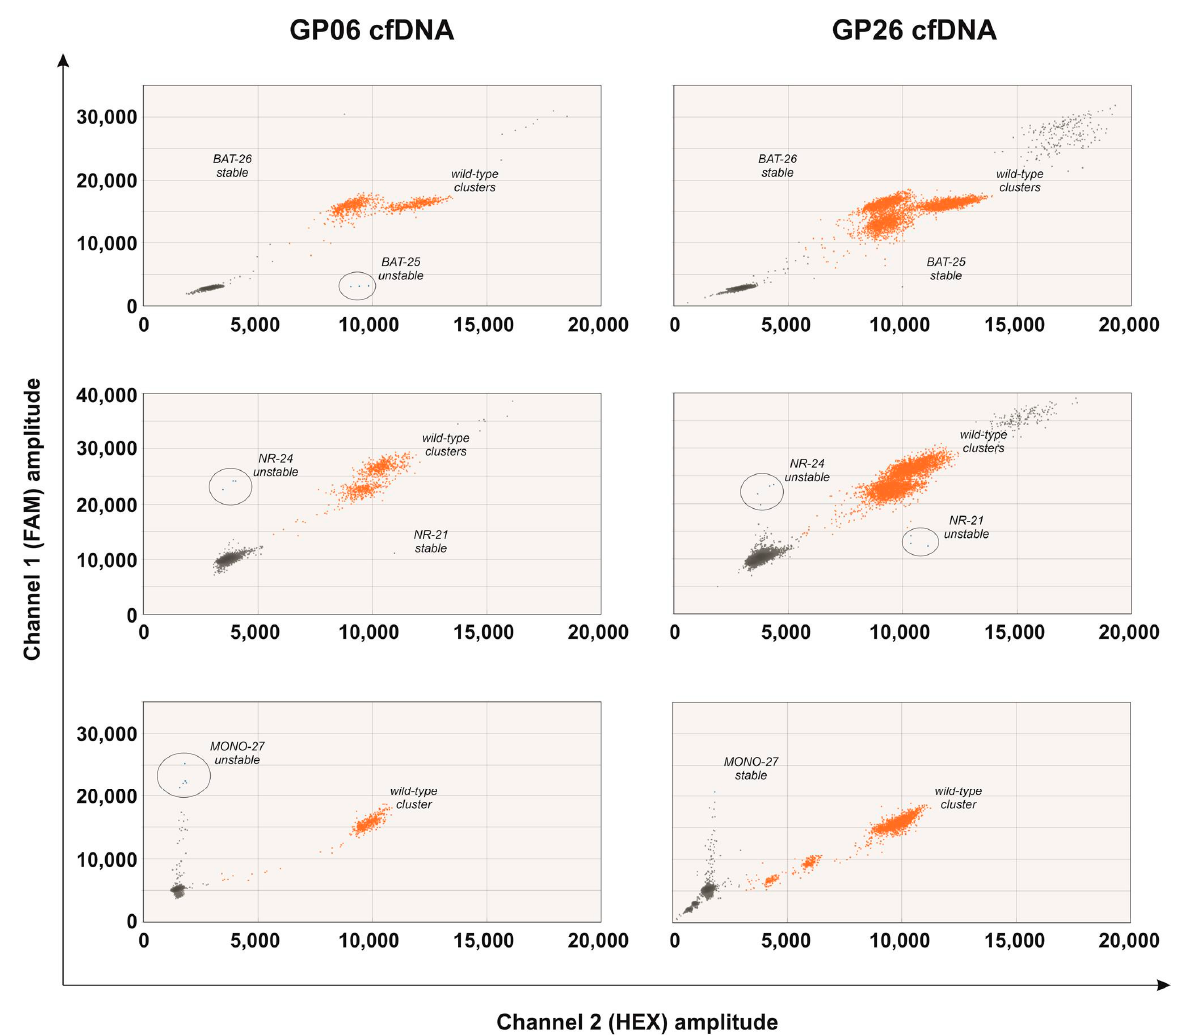
Figure 3. Two-dimensional plot of droplet fluorescence for the three ddPCR MSI assays (BAT-25 and BAT-26; NR-21 and NR-24 and MONO-27) performed in the cfDNA of patients GP06 and GP26. Wild-type molecules are in the orange clusters, and the microsatellite unstable molecules are in the blue clusters. The individual target is labeled on each plot. Circles identify loci with at least three positive droplets (unstable